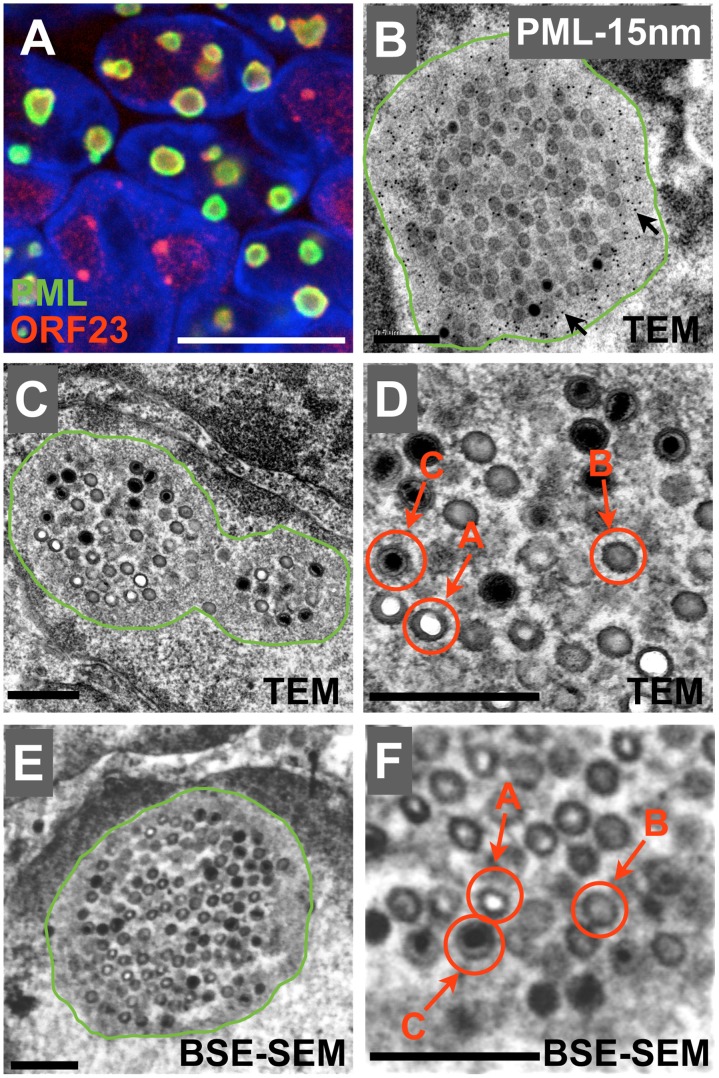
Visualization of PML cages and VZV nucleocapsids by confocal microscopy, TEM and SEM.(A–F) Melanoma cells that expressed doxycycline-induced PML IV were infected with VZV for 48 hours. (A) Analysis by confocal microscopy: permeabilized cells on coverslips were immunostained for PML (green) and ORF23 capsid protein (red); nuclei were stained with Hoechst (blue). Scale bar, 10 µm. (B) Immunogold TEM analysis: cells were high-pressure frozen, freeze-substituted, embedded in LR-White resin and then labeled with anti-PML polyclonal rabbit antibody and Protein A conjugated with 15 nm gold particles. Note the dense PML-gold labeling (arrows) in the amorphous layer (surrounded by a green line) that encloses the sequestered capsids. (C and D). Standard TEM for morphological analysis: cells were aldehyde-fixed, ‘en block’ stained for high contrast and then embedded in epoxy-resin. Note the electron dense amorphous PML layer (surrounded by green line) that encloses the clustered capsids. (D) Three types of capsids (A, B, C-type capsids, red arrows) can be distinguished by TEM. (E and F) Scanning EM analysis with a back-scattered electron detector (BSE) of the same sample as in C. Note the electron dense PML layer (surrounded by a green line) that encloses the sequestered capsids. (F) The three types of capsids (A, B, C-type capsids, red arrows) can also be distinguished by BSE-SEM. Scale bars in B–F are 500 nm.